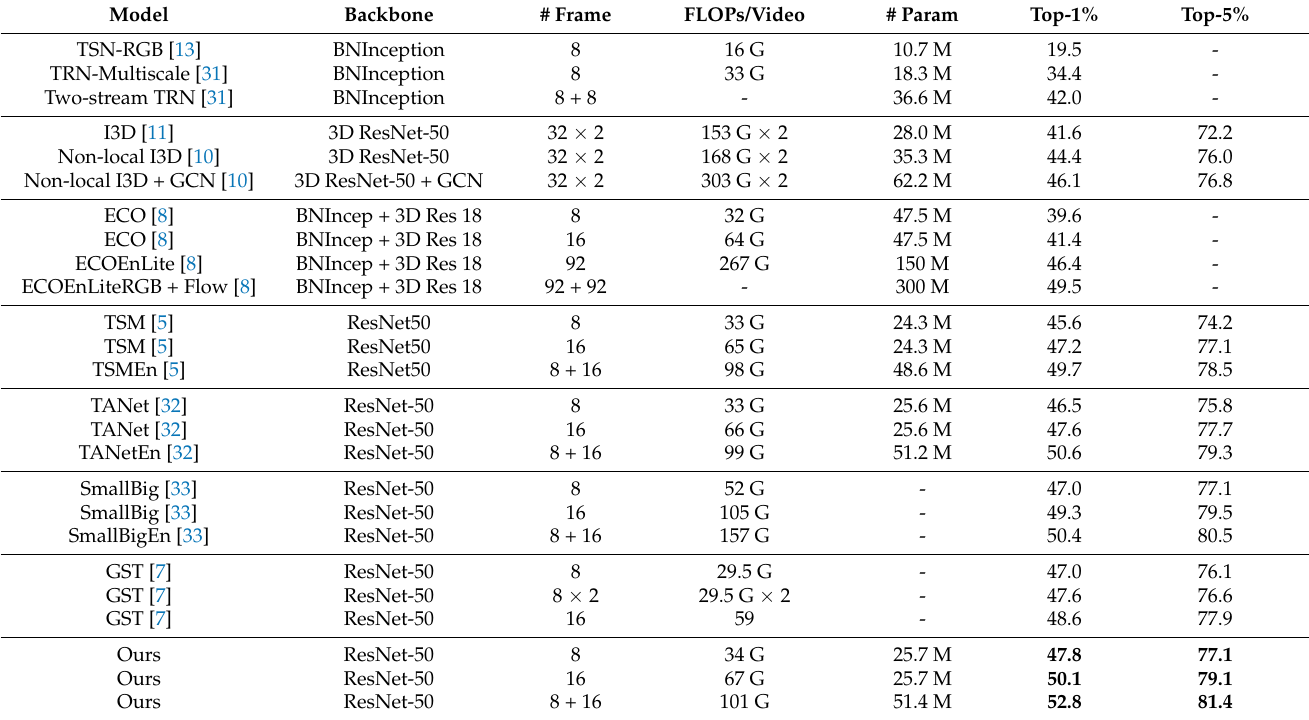
Table 3. Results on Something-Something-V1 compared with state-of-the-art methods (center crop, 1 clip).